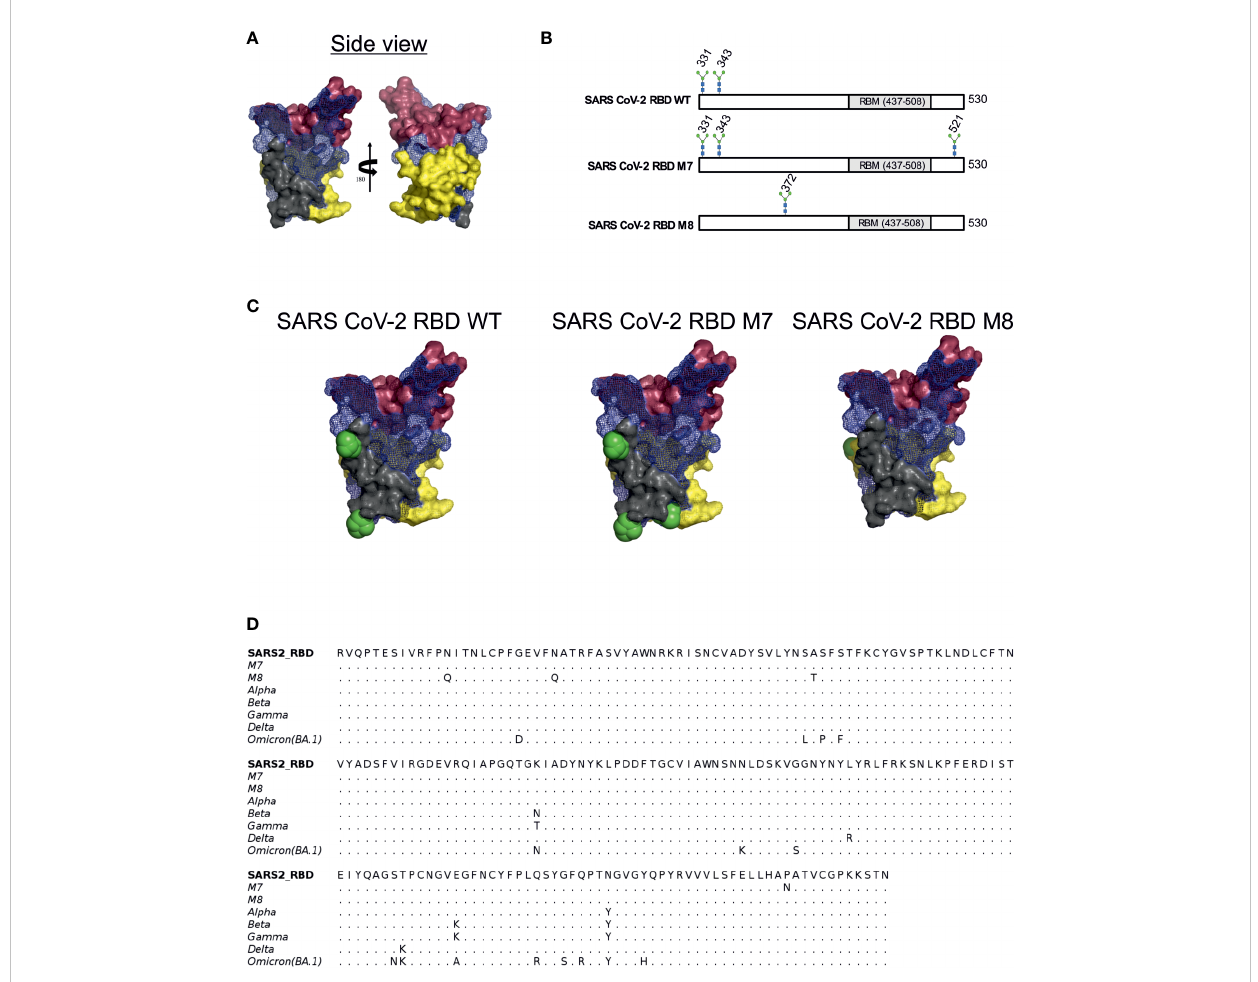
FIGURE 1 Rational immunogen design of glycan engineered SARS CoV-2 RBD mutants. (A) Mesh surface representation of SARS CoV-2 RBD protein. The epitope recognised by B38 is represented in red-brown solid surface, CR3022 in yellow solid surface, and S309 in grey solid surface. (B) The glycan sites in wild-type SARS-CoV-2 RBD, M7 and M8 designs are highlighted by the stick representation of sugar molecule. (C) Surface representation of wild-type SARS-CoV-2 and glycan engineered M7 and M8 with glycans shown as green spheres. (D) Multiple sequence alignment of RBD WT with M7, M8, and